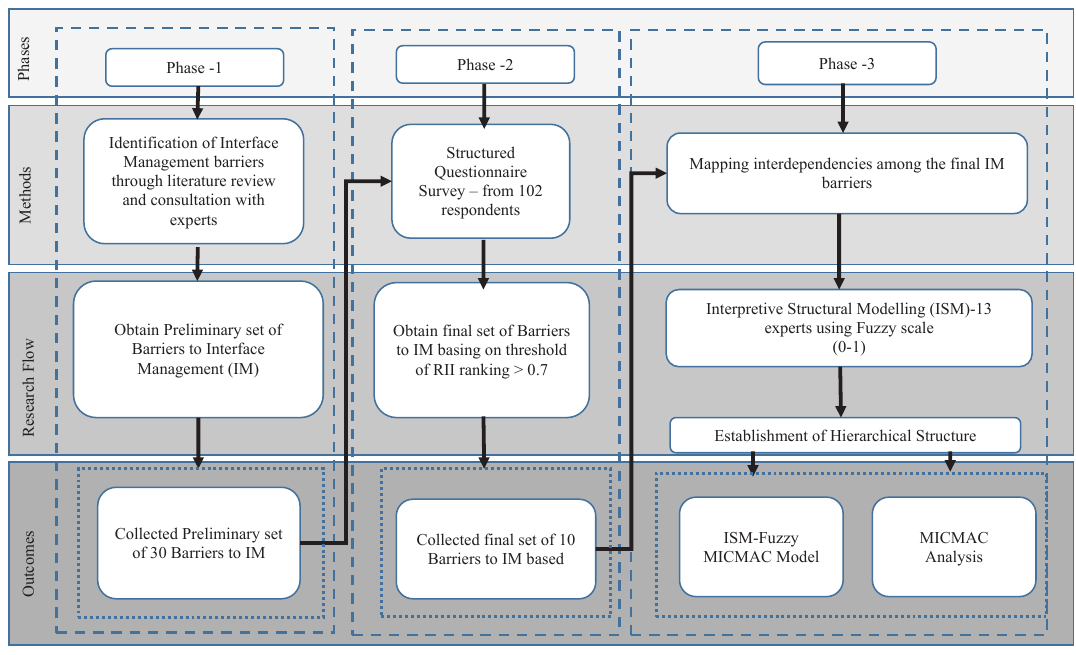
Figure 1. Analytical Research